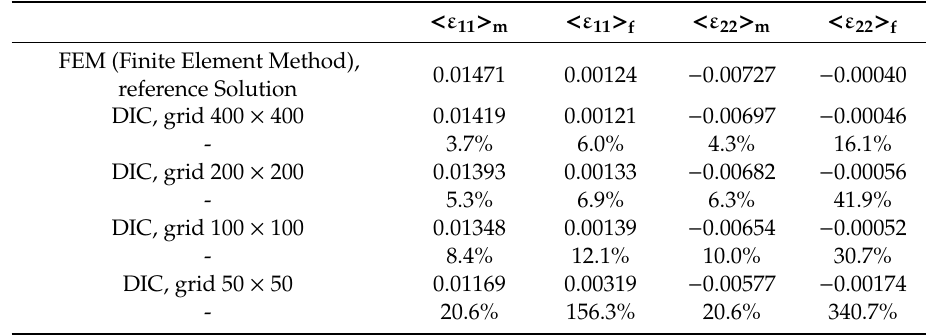
Table 4. Summary of results of the DIC Analysis involving di ff erent speckle patterns obtained for Material 2.